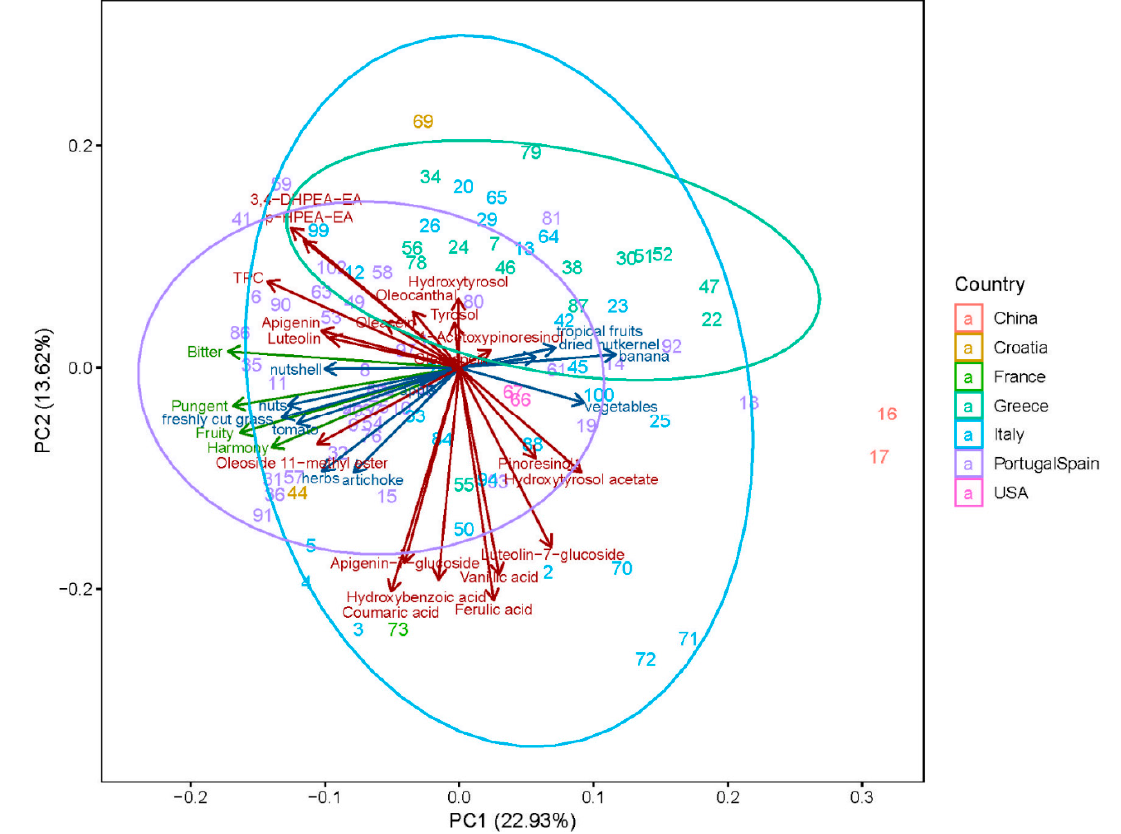
Figure 6. Principal component analysis for all of the analyzed sensory descriptors and the bioactive compounds. All of the twenty targeted ∆ phenolic compounds, the ∆ sensory and the ∆ aroma descriptors are showed.